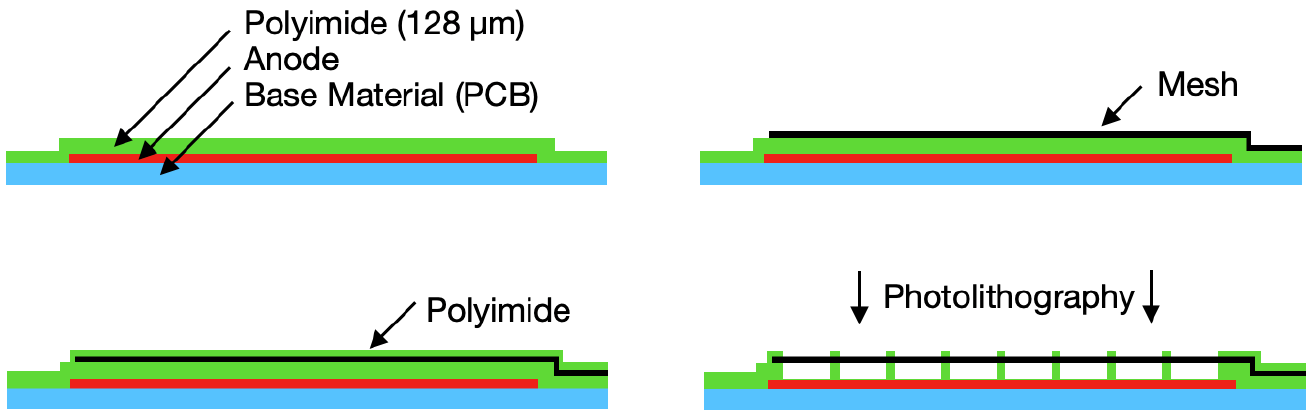
Figure 3. The main production steps of a bulk Micromegas. The mesh is laminated between polyimide layers. The material between the mesh and the anode is removed with a lithographic process, and only the supporting pillar and frame structures